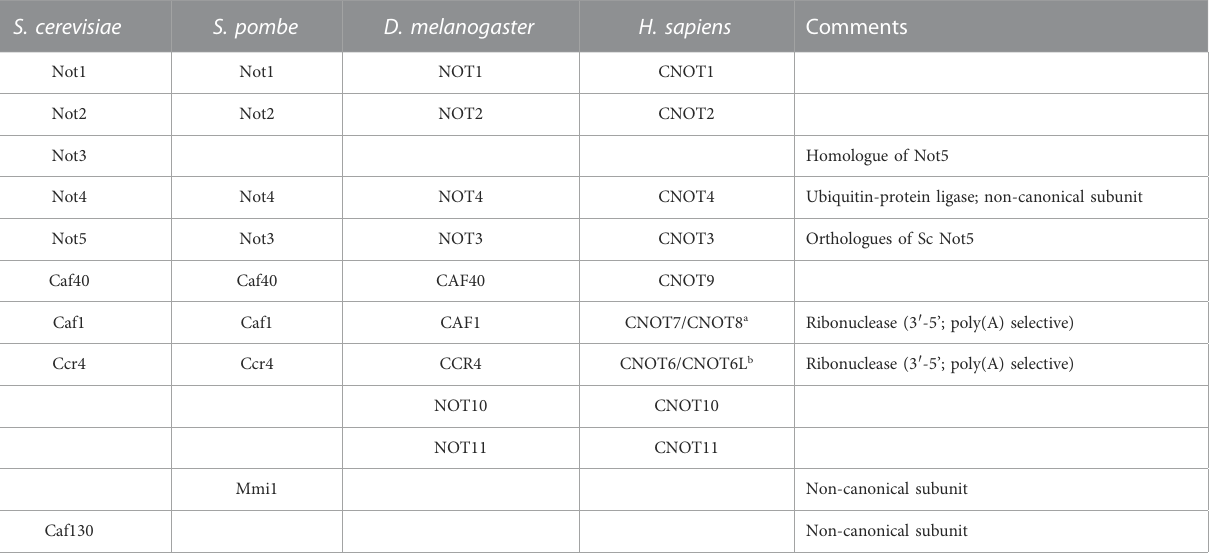
TABLE 1 Composition of eukaryotic Ccr4-Not